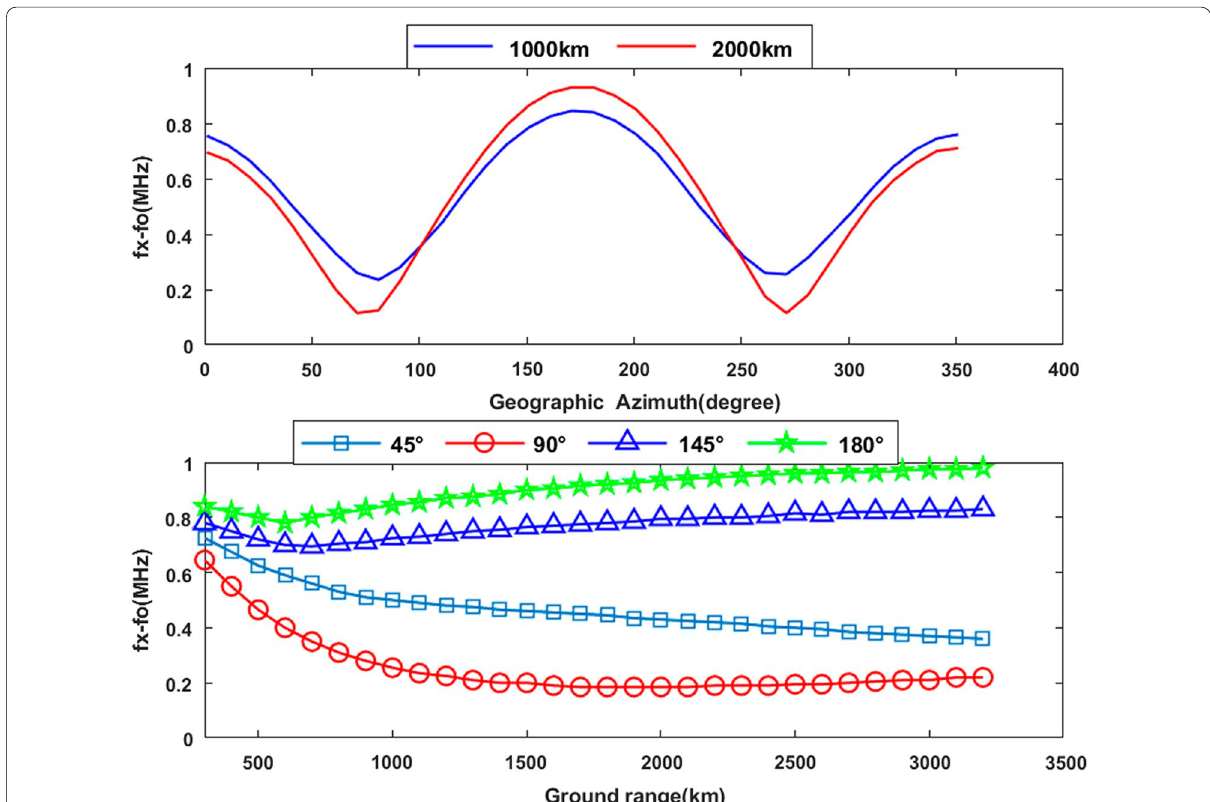
Fig. 14 Relationship of the separation with length and direction of propagation; upper diagram shows variability on direction of propagation, lower diagram shows variability on length of